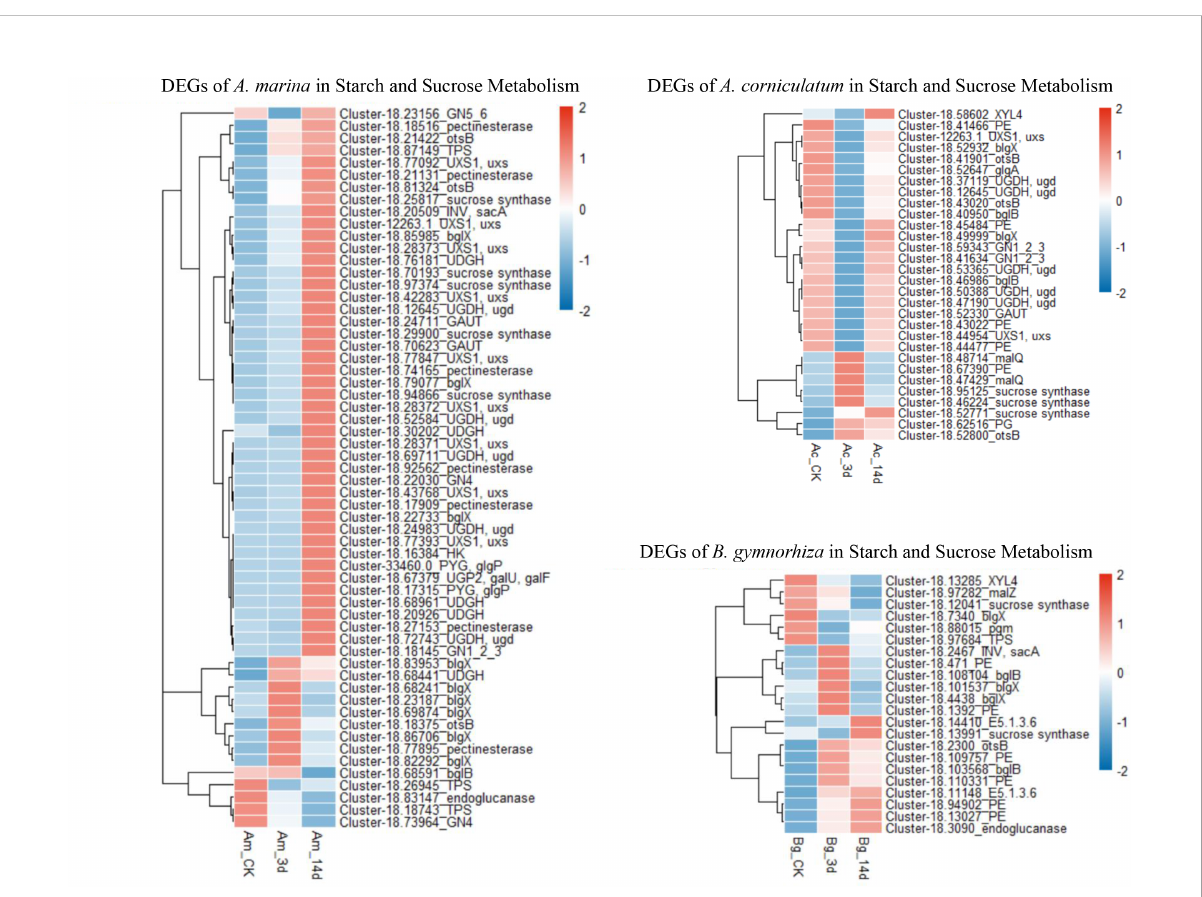
FIGURE 5 Regulation of starch and sucrose metabolism (KO00500) in Avicennia marina , Aegiceras corniculatum , and Bruguiera gymnorrhiza